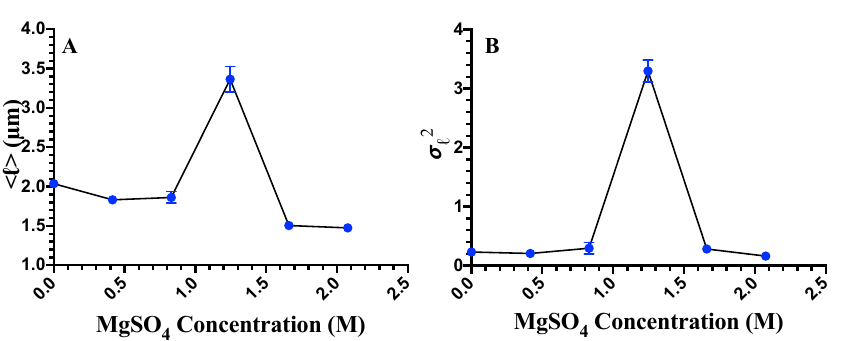
Figure 4. ( A ) Average length, (cid:104) (cid:96) (cid:105) , and ( B ) variance, σ 2 (cid:96) , as a function of MgSO 4 concentration. Since for concentrations > 1.25 M, cells undergo death, and therefore, both the average and the variance of cell length exhibit a maximum at 1.25 M.